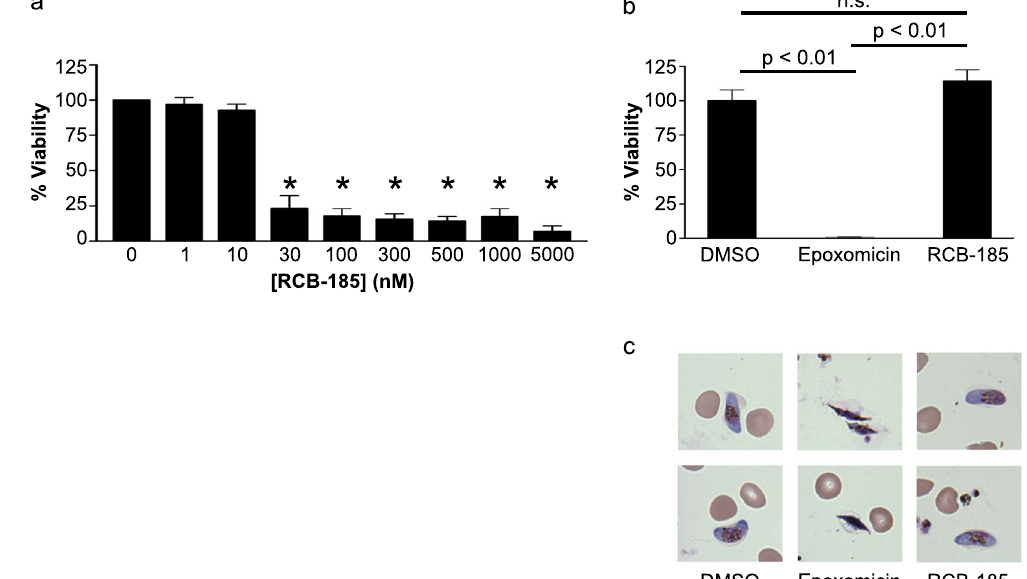
Figure 5. RCB-185 is active against sexually-committed P. falciparum parasites. ( a ) Gametocyte-committed trophozoites and schizonts were treated with RCB-185 (1 nM–5 uM) for 72 h and viability assessed by flow cytometry using the mitochondrial dye MitoProbe DiIC(1)5. Displayed are the means ± SEM from at least 2 independent biological replicates. Asterisks denote RCB-185 treatments that were statistically different than untreated parasites (p < 0.01). ( b ) Stage III/IV/V gametocytes were purified on a Percoll gradient and then treated with 5 μ M RCB-185 for 72 h. Parasites were stained with MitoProbe DiIC(1)5 and viability quantified by flow cytometry. 32.5 nM epoxomicin and 0.5% DMSO were used as positive and negative controls, respectively. While the well-characterized antimalarial agent epoxomicin efficiently kills mature gametocytes (p < 0.01), flow cytometry data indicate that RCB-185 lacks activity against mature gametocytes. Displayed are the means ± SEM from at least 2 independent biological replicates ( c ) Representative Giemsa-stained blood smears of parasites treated in ( b ) demonstrate that 5 μ M RCB-185 is inactive against stage III/IV/IV